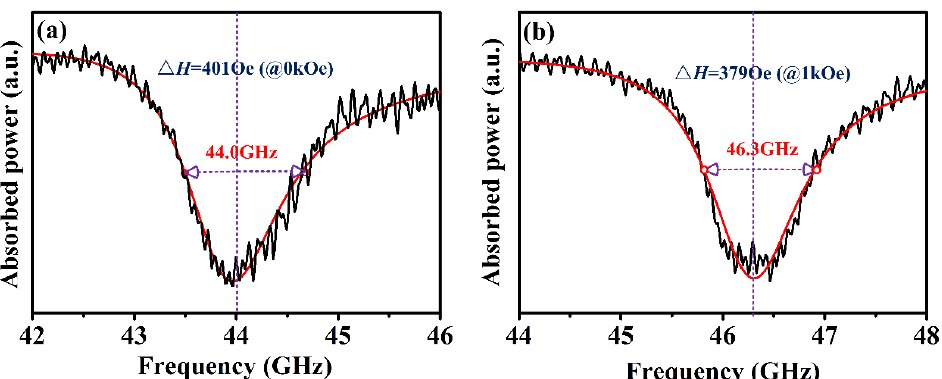
Figure 3. The dependence of the frequency response of absorbed power in a